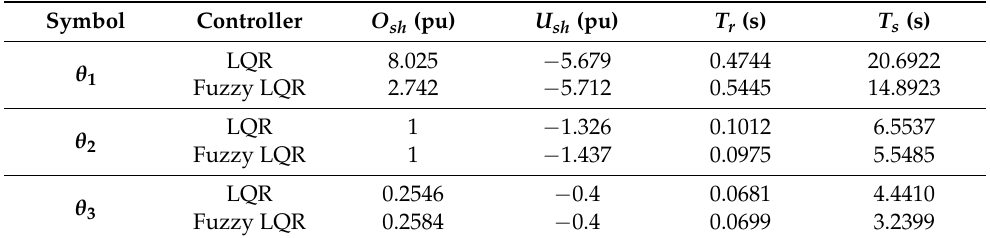
Table 7. Comparison performance of LQR and FLQR controllers in Case